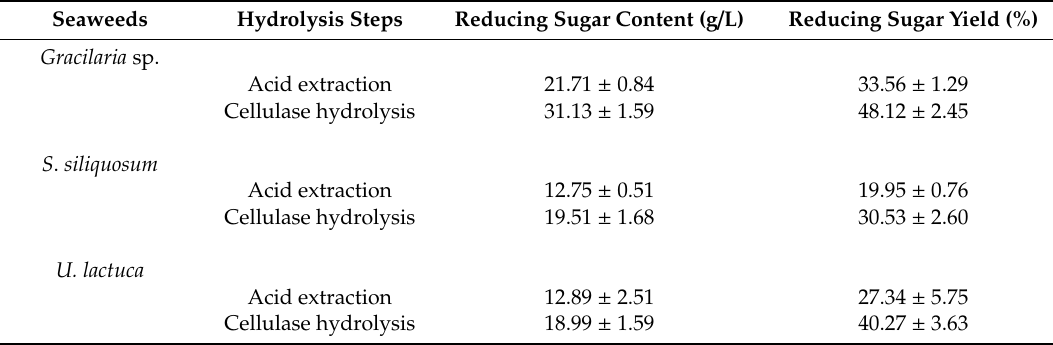
Seaweeds Hydrolysis Steps Reducing Sugar Content (g / L) Gracilaria